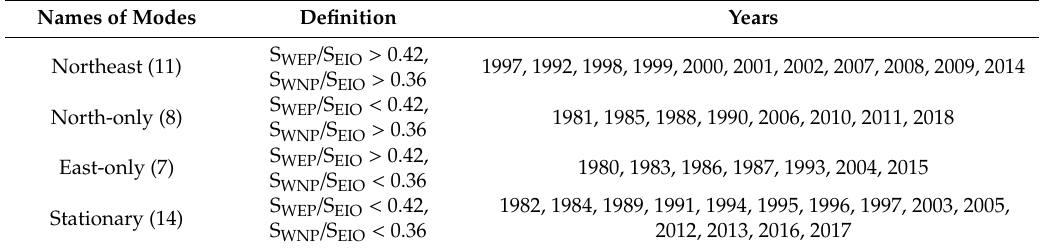
Table 1. List of specific years included in the relevant mode. S WEP , S WNP and S EIO represent the ISO strength over WEP, WNP and EIO, respectively. IO: equatorial Indian Ocean; WEP: western equatorial